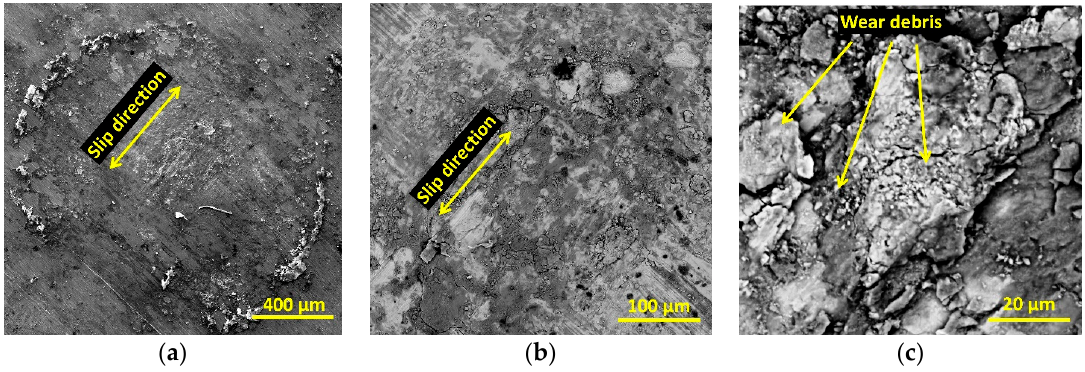
Figure 4. Impact of human saliva and its substitutes on friction coefficient values under stable